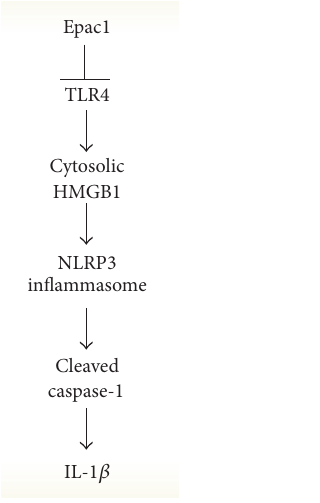
Figure 5: Schematic of the proposed regulation of the NLRP3 inflammasome by